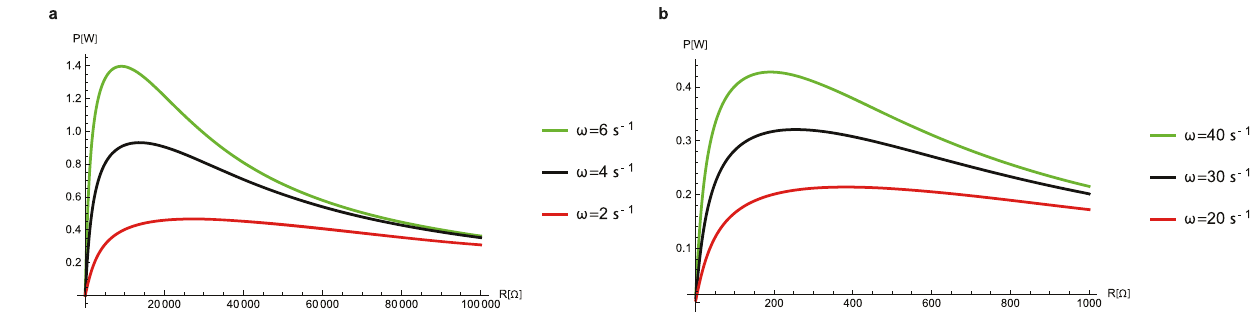
Fig. 5 The average power pro fi le against the electric load for different rotation frequencies. Curves are plotted for two different lubricating liquids, a PC and b IL mixture. Each case is presented for three different rotation frequencies (typical and different for each case, due to the difference in drag torques). Parameters: a N ¼ 10 2 , V ref ¼ 50V; b N ¼ 10 3 ; V ref ¼ 4V. Note that the optimal power regimes and structures for these two systems ( a and b ) are achieved for different number of stages, frequencies and voltages; and the graphs of the power, in a and b , have been plotted for different